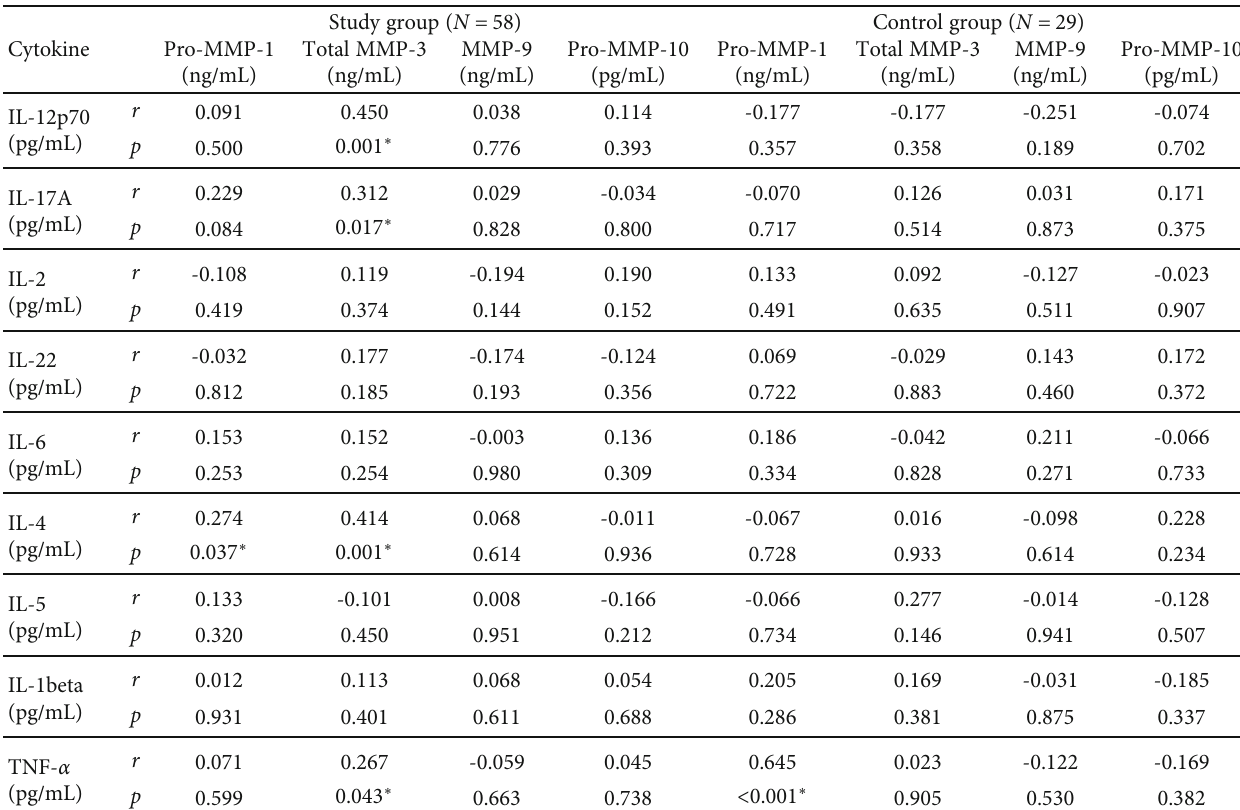
Table 5: Correlations between metalloproteinases and cytokines in psoriatic patients and in control group. ∗ indicates statistically signi fi cant di ff